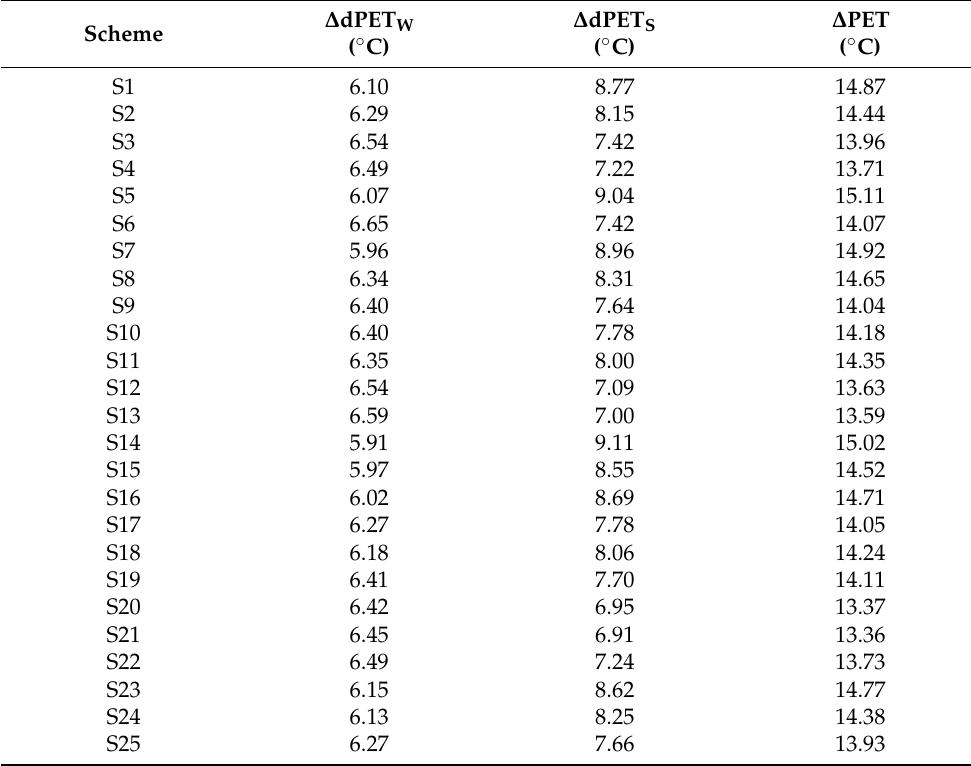
Table 7. The dPET, ∆ dPET W , ∆ dPET S , and ∆ PET values of each simulation scheme. Scheme